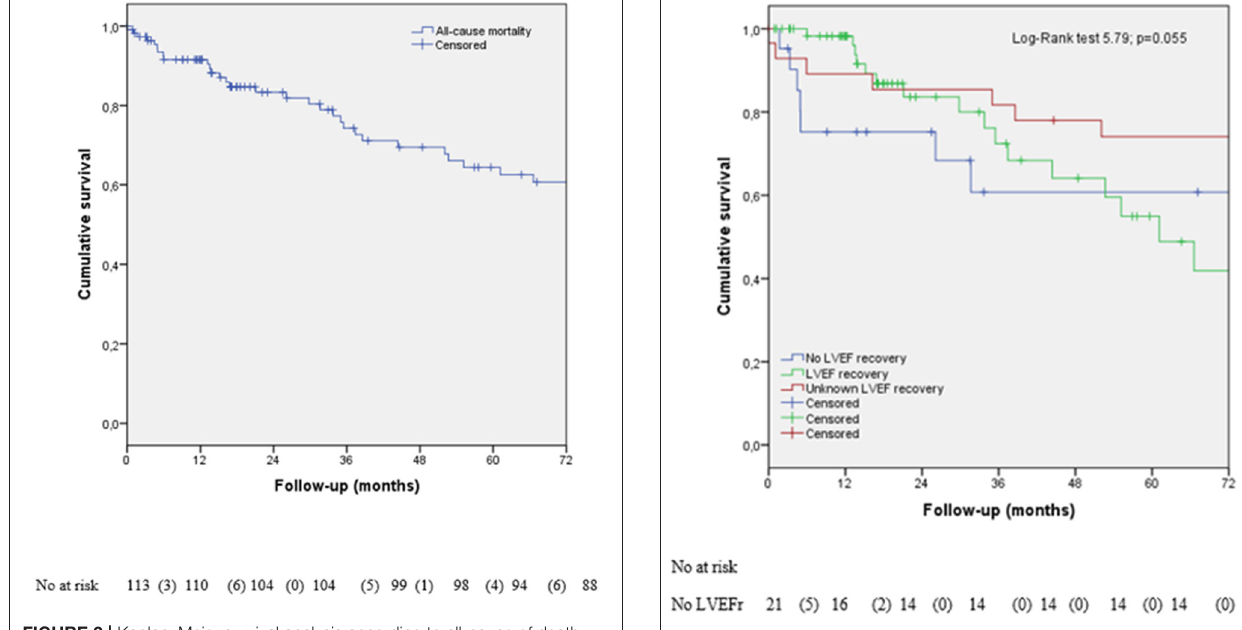
FIGURE 2 | Kaplan–Meier survival analysis according to all-cause of death.